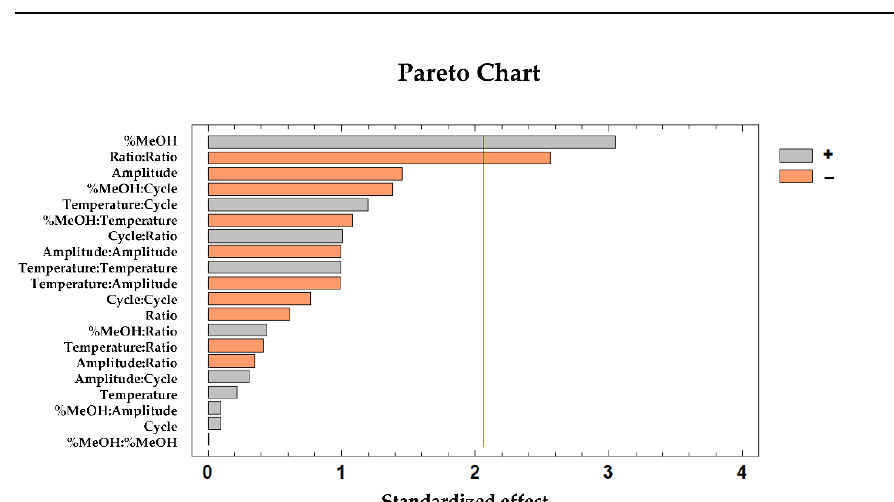
Figure 4. Pareto chart obtained from the BBD–RSM design of the antioxidant capacity of the mush- room sample extracts according to the DPPH method.